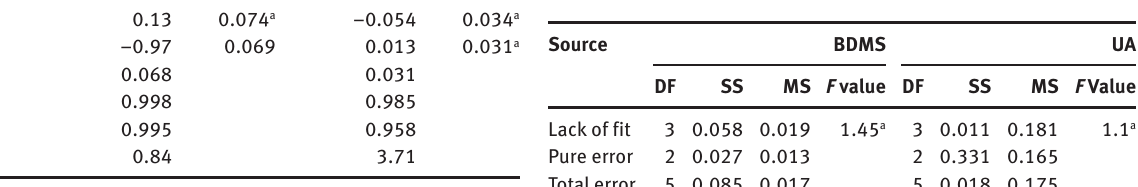
Table 4: Analysis of variance for the lack-of-fit testing for β , β - dimethylacryl shikonin (BDMS) and ursolic acid